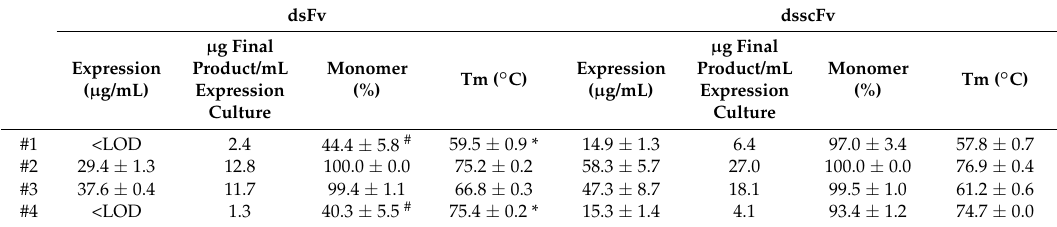
Table 1. Comparison of isolated dsFv and dsscFv. Following the 10-day transient expression in 293F cells, the expression level of dsFv#1–4 and dsscFv#1–4 proteins in the culture supernatant was measured by Octet. Proteins were purified from the supernatant using Ni 2+ -NTA resin, and the purified proteins